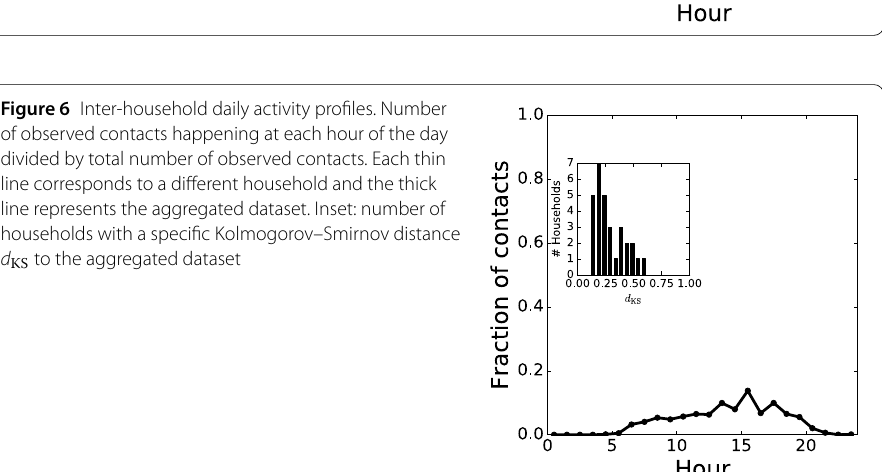
Figure 5 Intra-household daily activity profiles. Number of observed contacts happening at each hour of the day divided by total number of observed contacts. Each thin line corresponds to a different household and the thick line represents the aggregated dataset. Inset: number of households with a specific Kolmogorov–Smirnov distance d KS to the aggregated dataset